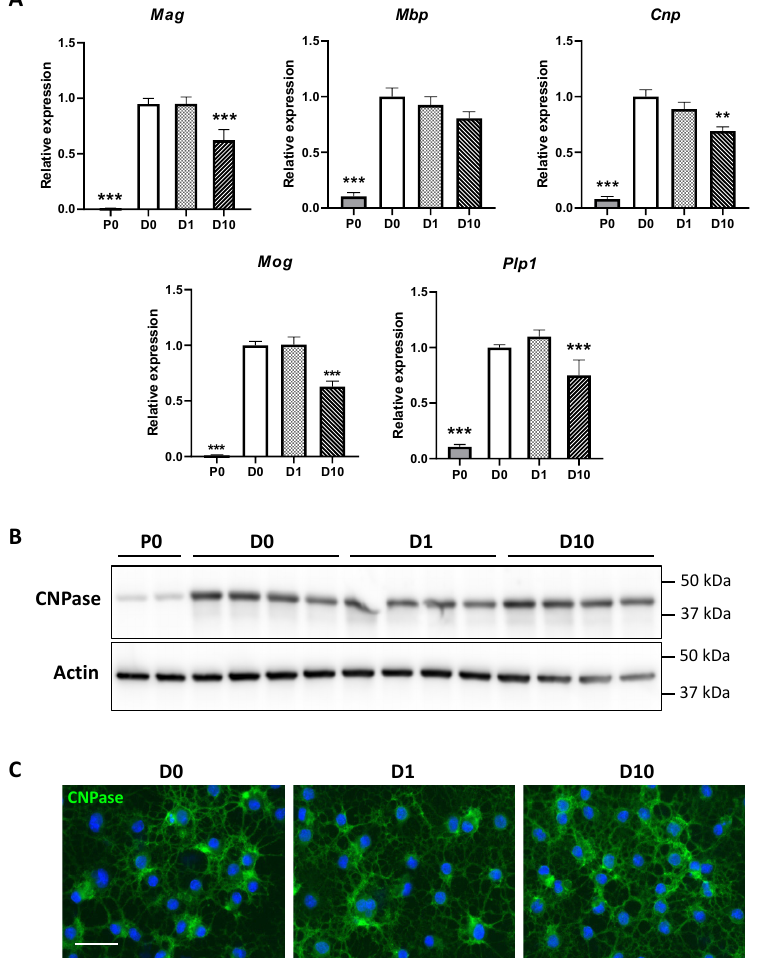
Figure 2. Myelin gene expression and CNPase immunoreactivity in Oli-neu cells: ( A ) Gene expression analysis of myelin proteins: myelin basic protein ( Mbp ), myelin-associated glycoprotein ( Mag ), 2 ′ ,3 ′ -cyclic nucleotide 3 ′ phosphodiesterase ( Cnp ), myelin oligodendrocyte glycoprotein ( Mog ), and proteolipid protein 1 ( Plp1 ), ( N = 6–9), relative expression was normalized to reference gene Rpl13a , all groups were compared to D0 control group, (one-way ANOVA and Dunnett multiple comparison post-test, ** p < 0.01, and *** p < 0.001); ( B ) Western blot of CNPase and actin; ( C ) CNPase staining by immunocytofluorescence, with DAPI counterstaining. Scale bar, 50 µM. P0—proliferating cells, D0—differentiated control cells, D1—differentiated cells exposed to BPA 1 µM, D10—differentiated cells exposed to BPA 10 µM.